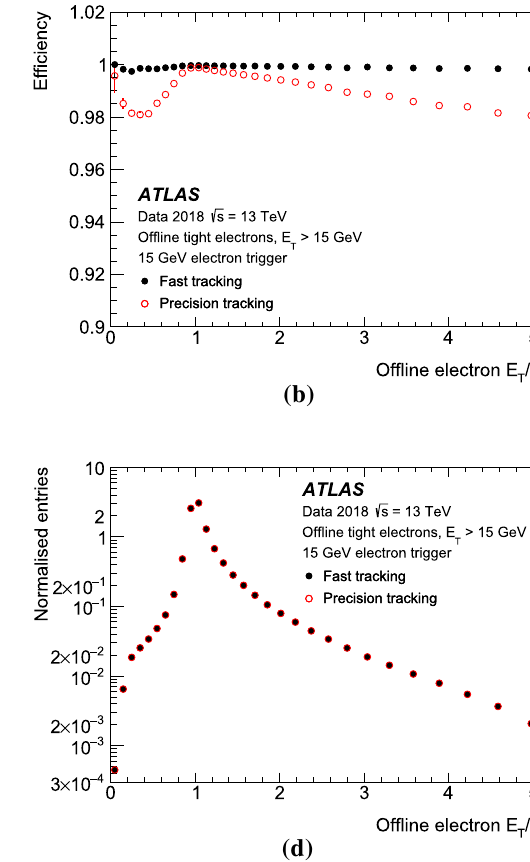
bution of E T / p T for the offline electron candidates. For the efficien- cies versus offline electron candidate E T and p T , only candidates with E T / p T > 0 . 8 are